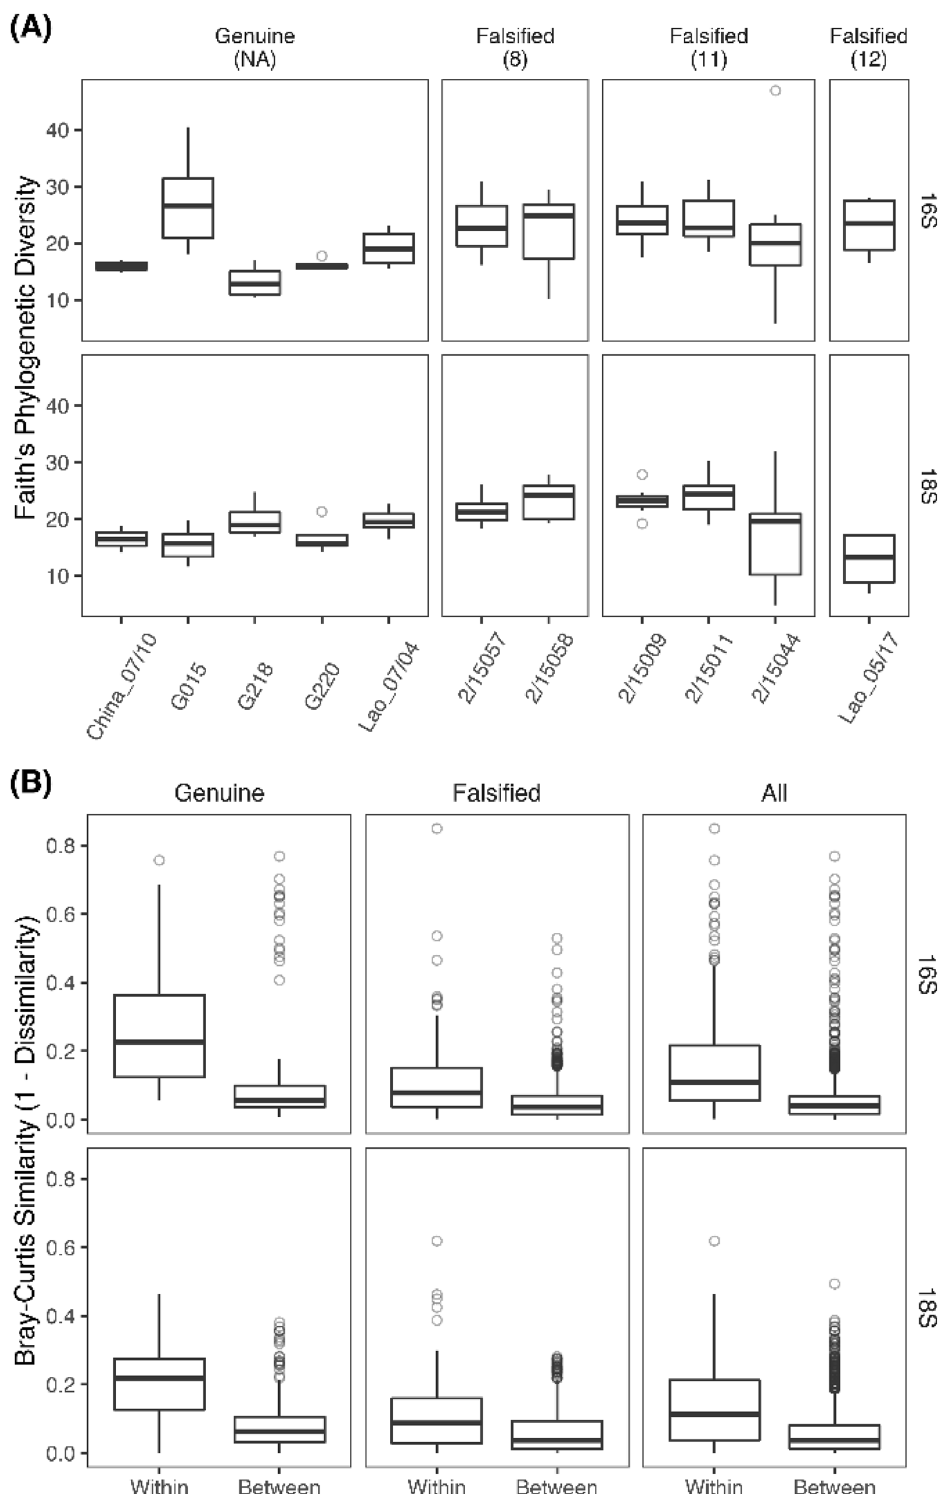
Figure 2. ( A ) 16S and 18S Alpha diversity (Faith PD) classified by tablet type (genuine or falsified) and by packaging type (in brackets) and ( B ) 16S and 18S Bray–Curtis similarities within and between samples for genuine, falsified and all